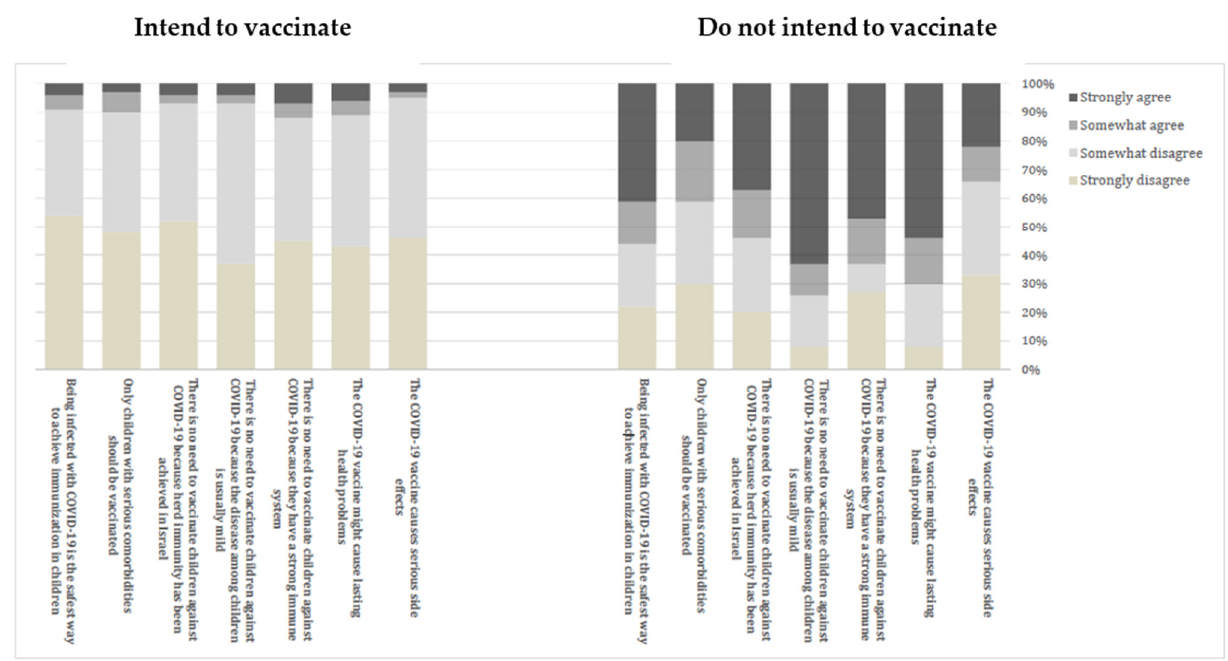
Figure 2. Parents’ perception of COVID-19 vaccine—difference between parents who intend to vaccinate their children and parents who do not intend to vaccinate.